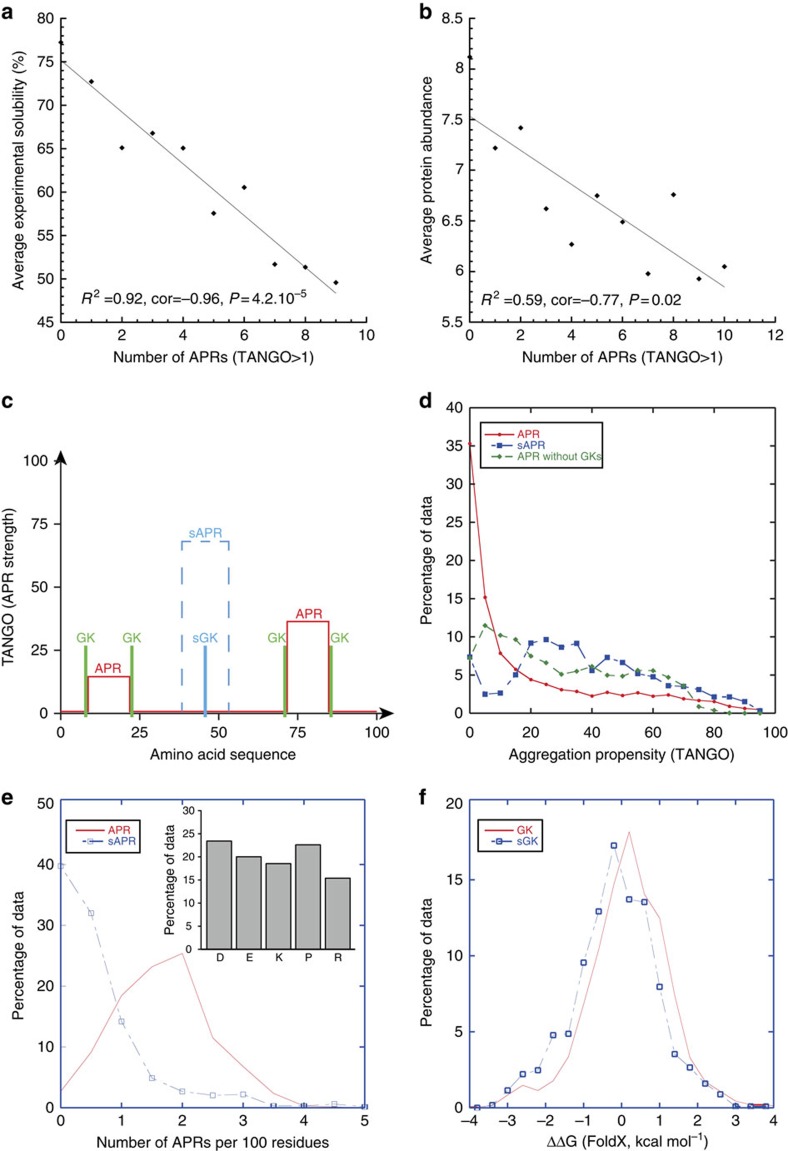
APRs and gatekeepers in natural polypeptide sequences.(a) The scatterplot of the average experimentally determined solubility517 of E. coli proteins grouped by the number of APRs in their sequence displays an anti-correlation, showing that on average protein solubility decreases with increasing number of aggregation prone sequences. (b) A similar plot to A, but now for protein abundance in E. coli in vivo
517. Although the anti-correlation is weaker, the trend suggests that cellular abundance is also limited by the number of APRs in its sequence. (c) Schematic representation depicting the TANGO profile of a typical naturally occurring polypeptide stretch of 100 amino acids, containing two APRs (red) each flanked by an N-terminal as well as a C-terminal gatekeeper (green), as well as one suppressed APR (blue) controlled by a single suppressing gatekeeper. (d) A density plot of the TANGO scores in the set of 634 structurally diverse proteins (red), showing a strong bias towards lower scores. In the absence of gatekeeper residues, this distribution is biased towards higher scores (green). The TANGO scores of the suppressed APRs (blue) show a more even distribution including higher scoring regions. (e) Density plot showing the number of APRs occurring per 100 amino acids in 634 structurally diverse proteins (red line). The blue line shows the number of ‘suppressed APRs', which are not detected by TANGO in the WT sequence, but show up after mutation of a single Asp, Glu, Lys, Arg or Pro residue to Ala. If mutation of such a residue reveals an APR that is undetectable in the WT sequence, we call that residue a ‘suppressing gatekeeper'. The inset shows the frequency of the amino acid type of suppressing gatekeepers. (f) Density plot of the contribution of gatekeeper residues to the overall thermodynamic stability of the native state of the protein as calculated by FoldX (red). The same plot for the suppressing gatekeepers in the same proteins (blue) is very similar.